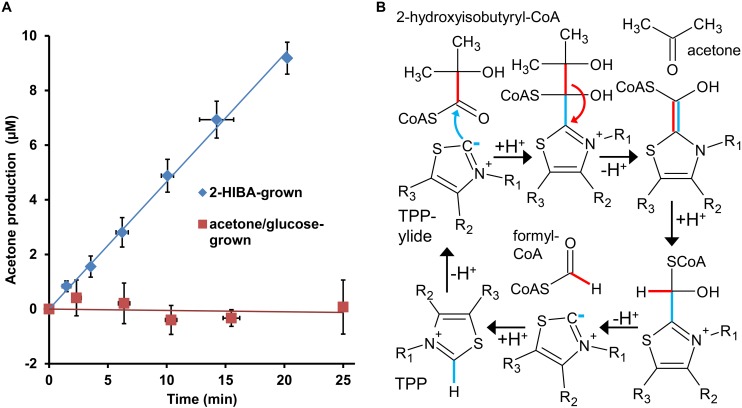
2-Hydroxyisobutyryl-CoA lyase activity in strain A. chiangmaiensis DSM 45062. (A) TPP-dependent acetone formation from 2-hydroxyisobutyryl-CoA in crude extracts of cells grown on main carbon sources as indicated. The lyase activity obtained from 2-HIBA-grown cells amounts to 2.9 ± 0.1 nmol min–1 mg protein–1, while it is absent when the strain was incubated on acetone or glucose. (B) Mechanism for the reverse acyloin condensation of 2-hydroxyisobutyryl-CoA proposed to be catalyzed by the lyase from strain DSM 45062. The TPP-dependent reaction starts by deprotonation of the cofactor to yield the active ylide form. For simplicity, only the thiazole ring of TPP is shown.